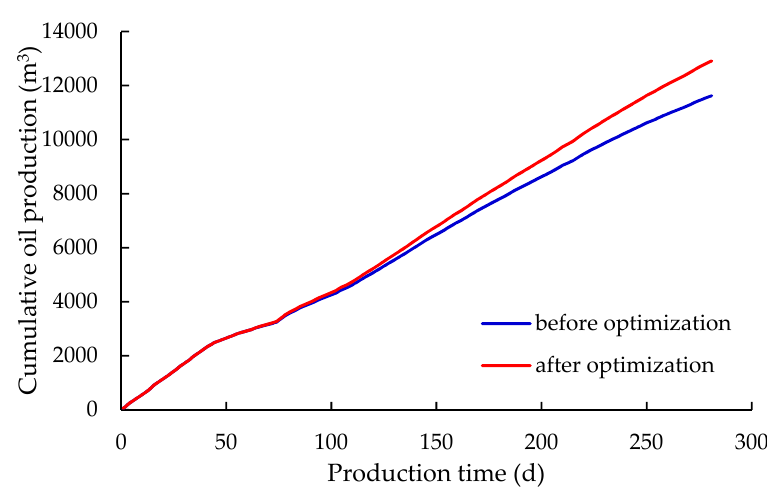
Figure 9. Comparison of cumulative oil production before and after optimization.